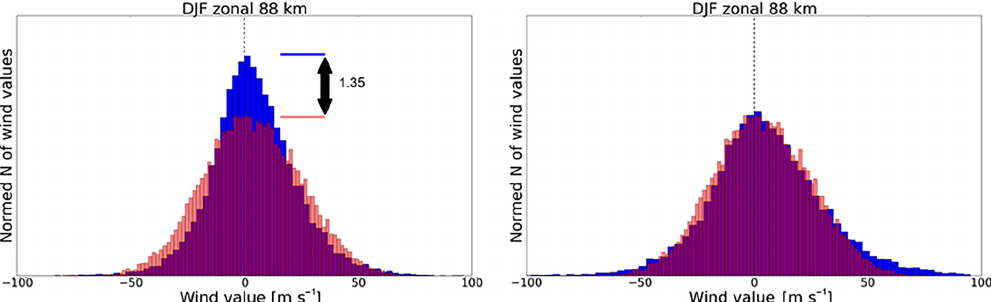
Figure 11. Comparison of sorted hourly wind values according to season, here DJF. MR (red) with values determined by the radar, MF (blue) with original values (left side), and values multiplied (right side) with a proportionate number according to the correction function of Table 3 to receive the same shape as the MR.